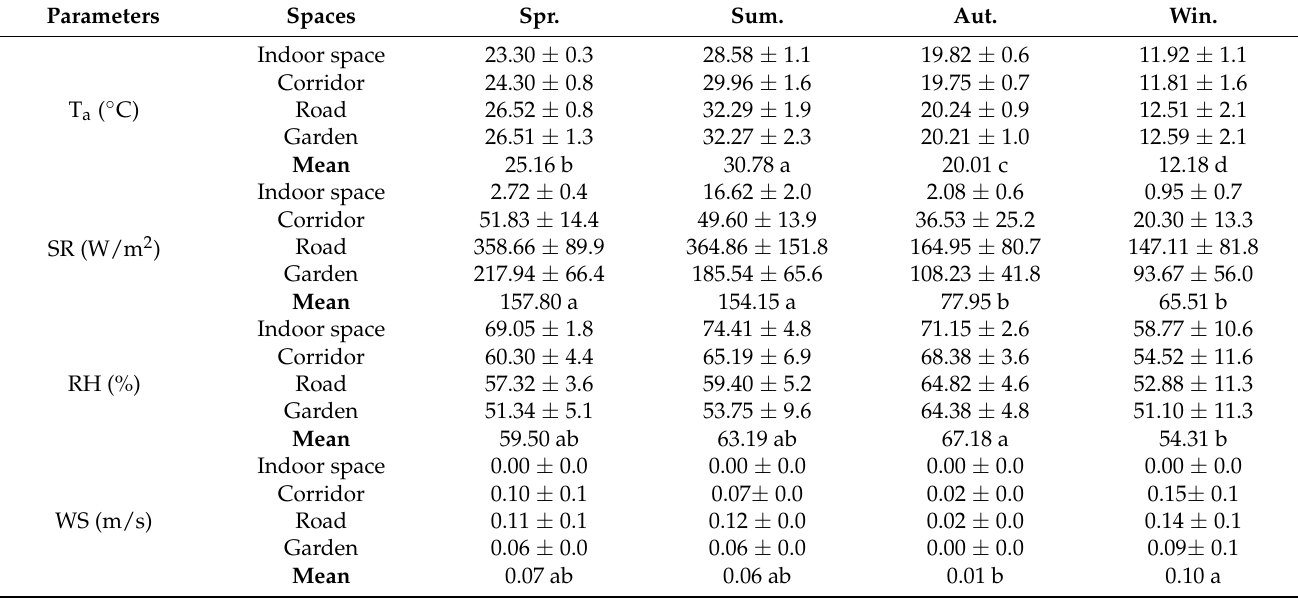
Table 3. Seasonal mean values of the microclimate parameters in four spaces.